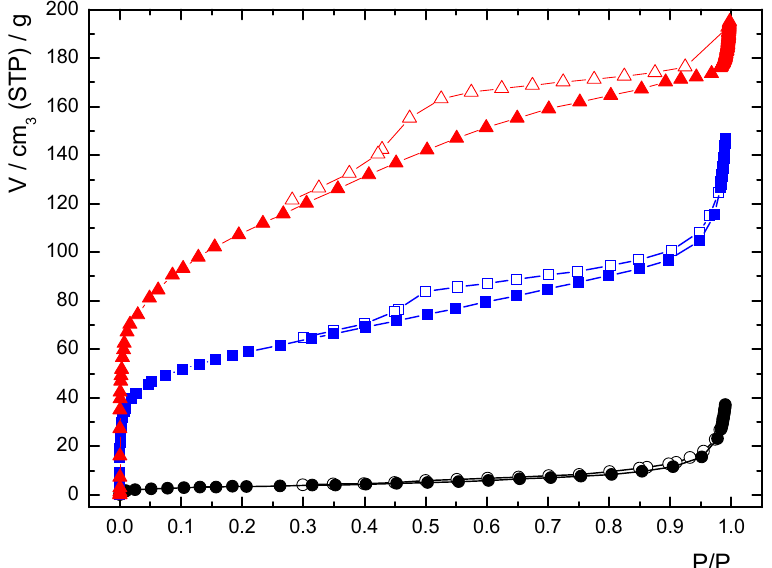
Figure 4. Nitrogen adsorption isotherms for ICR-9Cryst (black), ICR-9B (blue), and ICR-9A (red) at 77 K; adsorption is marked with full symbols and desorption with empty symbols.